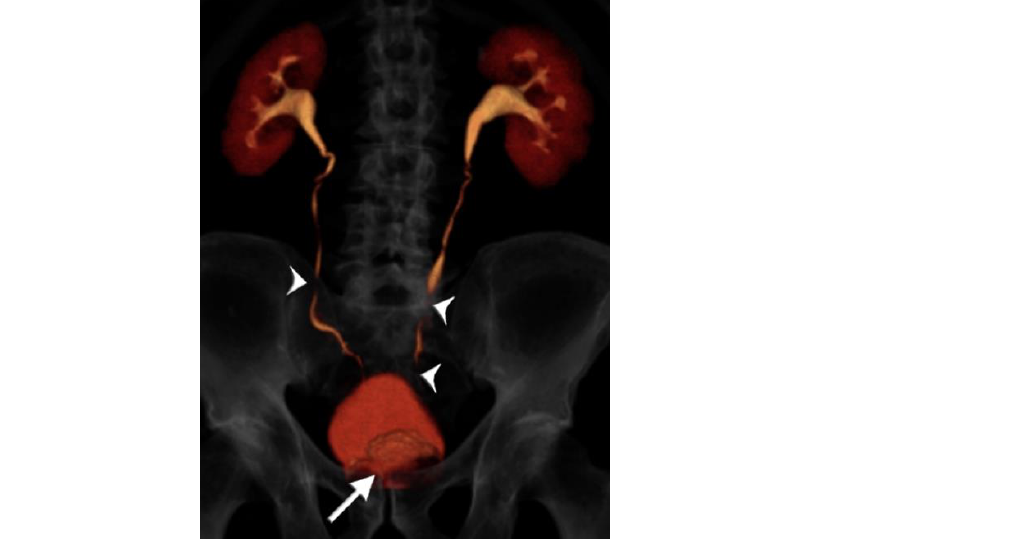
Figure 4. 75 year-old male with gross hematuria imaged with single-bolus CT urography. Volume- rendered image of the excretory phase shows near complete contrast opacification of the ureters, apart from very short unopacified segments (arrowheads). There is an enlarged prostate indenting the urinary bladder base (arrow). There is no upstream hydroureteronephrosis and the image quality was deemed adequate. The total table time was 11 min and the dose-length product was 870 mGy·cm.